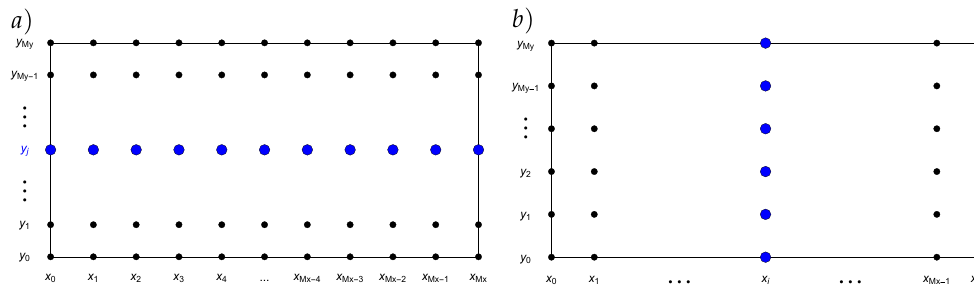
Figure 1. Numerical solution in horizontal direction (for a fixed node y j ) ( a ) and vertical direction (for a fixed node x i ) ( b